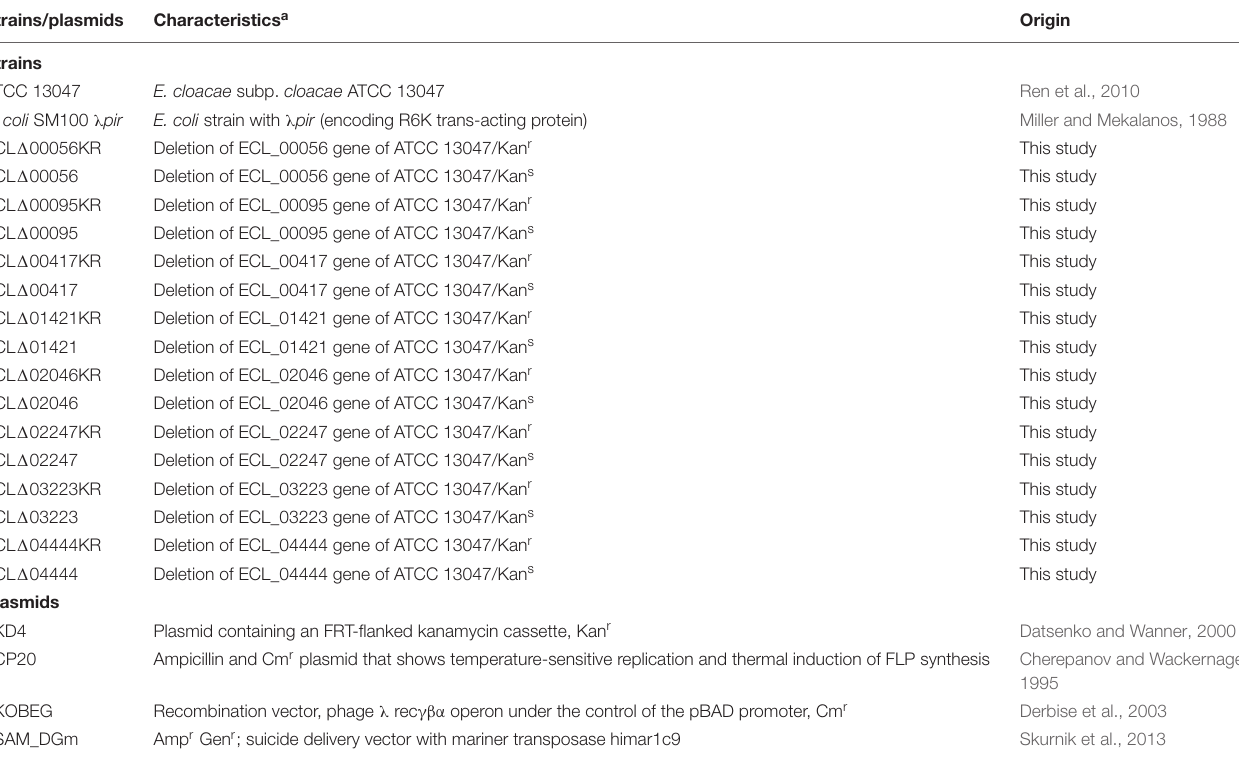
TABLE 1 | Bacterial strains and plasmids used in this